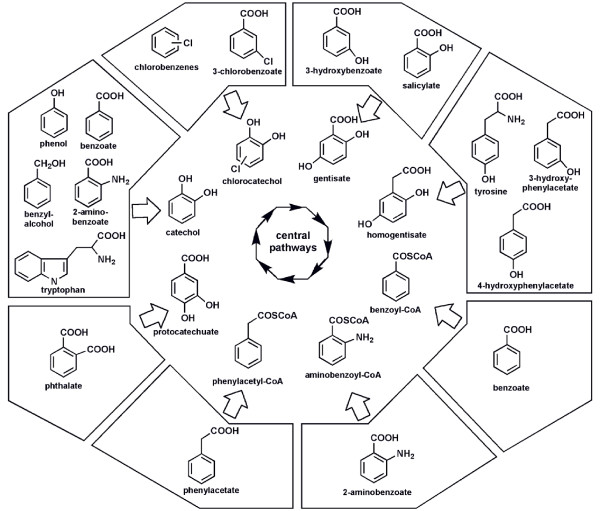
Overview of the degradation capacity of aromatic compounds by B. petrii. Aromatic compounds (boxed) are funneled through a variety of peripheral reactions (represented by arrows) into central intermediates, which are then processed by a central pathway to TCA cycle intermediates. However, neither salicylate nor phenylacetate could be used by B. petrii as sole source of carbon and energy (data not shown), probably due to the absence of a ferredoxin reductase encoding gene within the salicylate 5-hydroxylase encoding gene cluster (Bpet2804-2806 cluster), and an incomplete paaZ gene in the phenylacetate catabolic gene cluster (Bpet 1923–1935). 4-hydroxyphenylacetate is used as sole source of carbon and energy (data not shown), even though no gene with similarity to those encoding 4-hydroxyphenylacetate 3-hydroxylase was found in the genome (see Methods for experimental details).